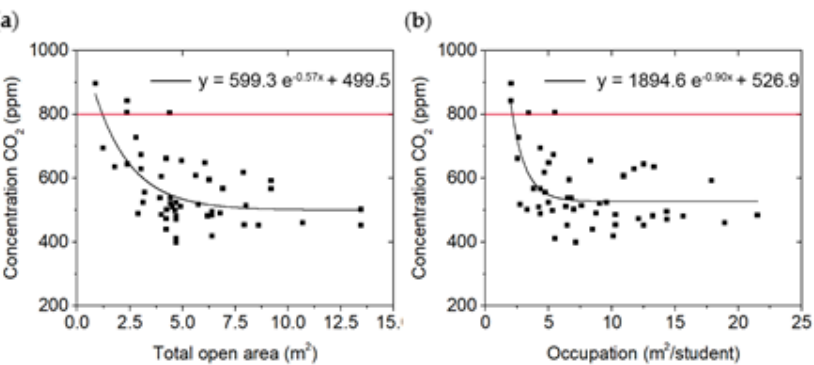
Figure 9. ( a ) CO 2 concentration versus total open area (m 2 ); ( b ) CO 2 concentration versus occupation density (m 2 /student). Red line indicates the REHVA CO 2 concentration limit recommendation.